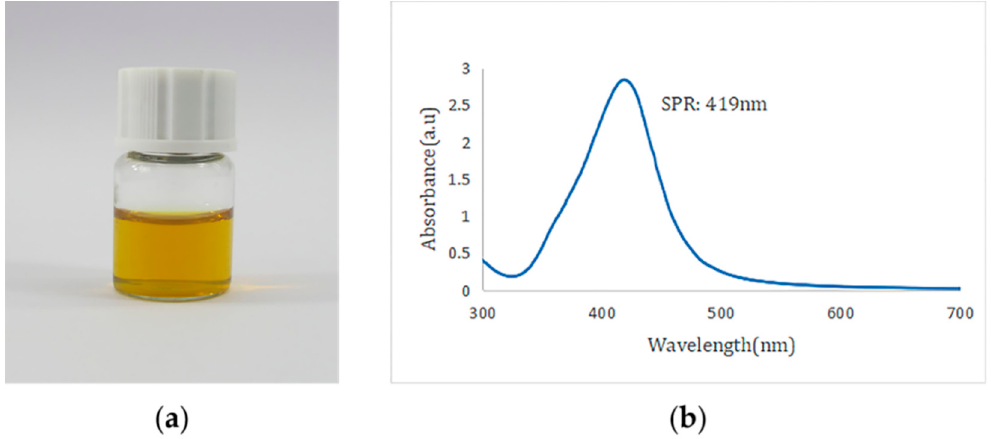
Figure 1. ( a ) Glycyrrhizin-reduced AgNPs in natural light, ( b ) UV-Vis spectra of glycyrrhizin-reduced AgNPs.